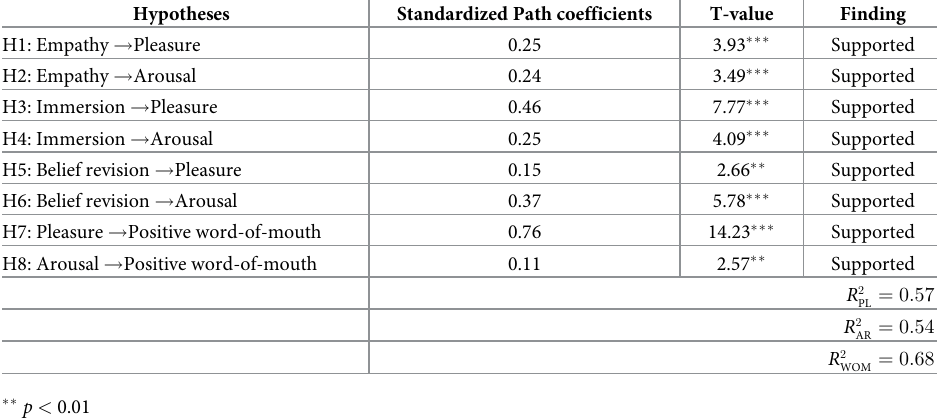
Table 3. Results of hypothesis testing